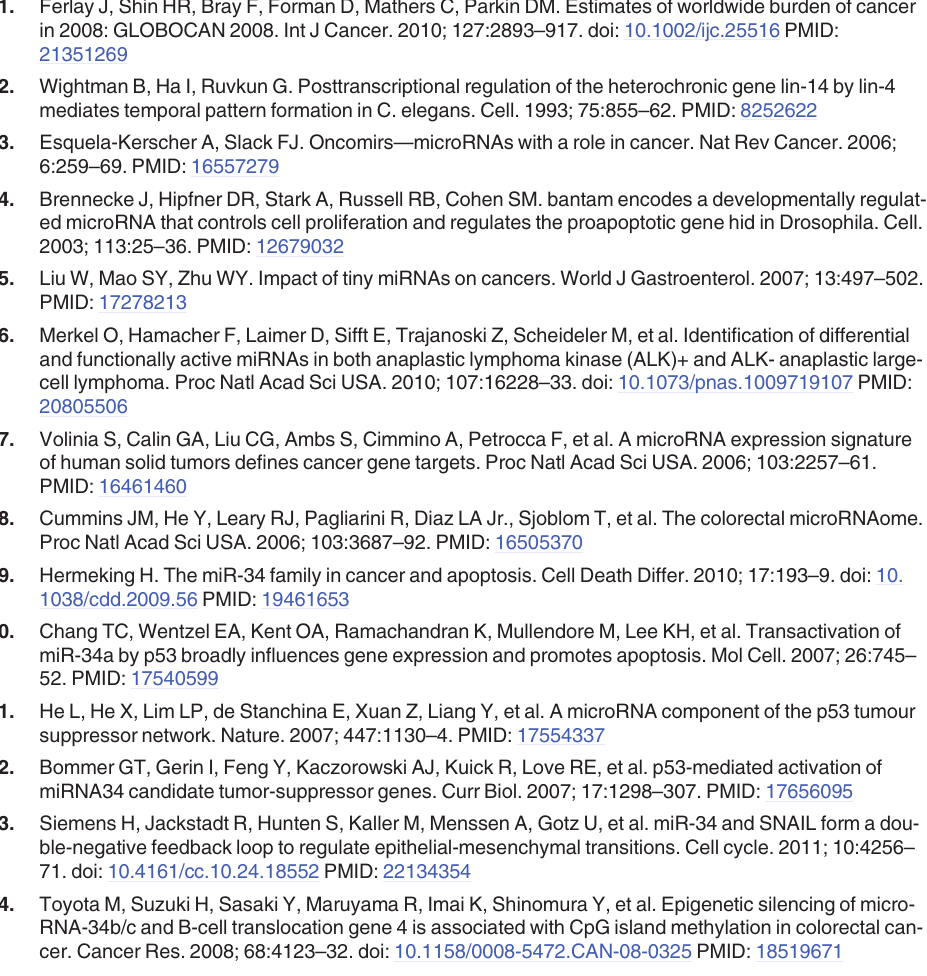
S2 Table. List of Transcription Regulators that are potentially involved with miR-34b/c ex- pression predicted by Ingenuity Pathway Analysis in 56 colon tumors. S3 Table. List of Transcription Regulators that are potentially involved with miR-34a ex- pression predicted by Ingenuity Pathway Analysis in 56 colon